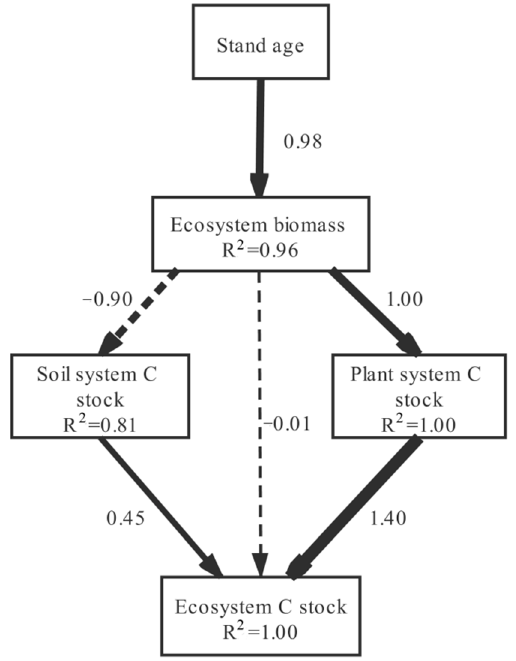
Figure 8. Structural equation model of the relationship between C stocks, stand age, and plant biomass. Numbers on arrows are standardized path coefficients; arrow width is proportional to the standardized coefficient; continuous and dashed arrows indicate positive and negative relationships, respectively. Chi-squared = 2.782, df = 4, P = 0.595, GFI = 0.895, RMR = 0.124, RMSEA = 0.000, NFI = 0.987, RFI = 0.968.